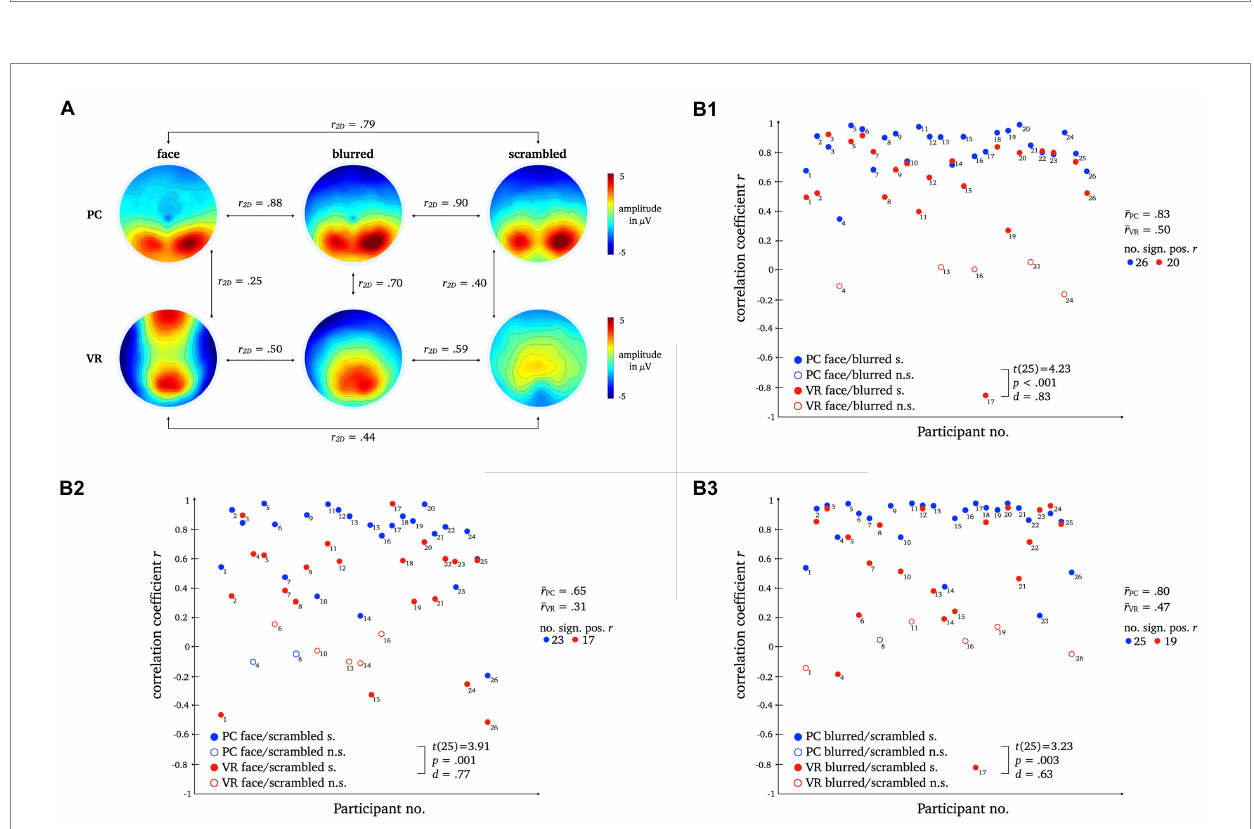
FIGURE 10 L1 topographies with 2D-correlation coefficient r for within and between modality comparisons [panel A ]. The scatter plots illustrate individual correlation coefficients for stimulus type comparisons between modalities: Face vs. Blurred [panel B1 ], Face vs. Scrambled [panel B2 ] and Blurred vs. Scrambled [panel B3 ]. T -Test statistics, mean correlation coefficients and number of significant correlation coefficients are